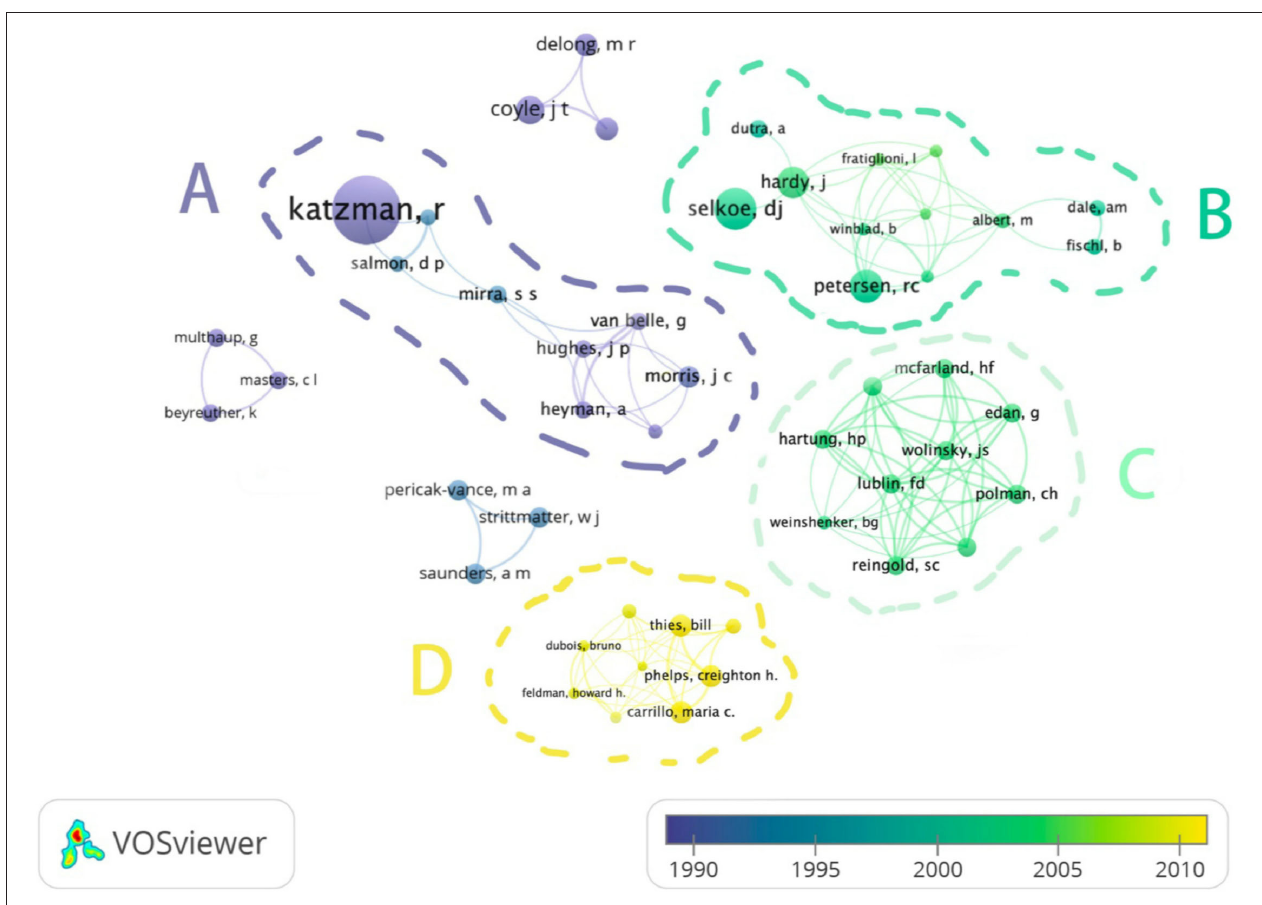
FIGURE 3 | The connections between authors in 100 top-cited